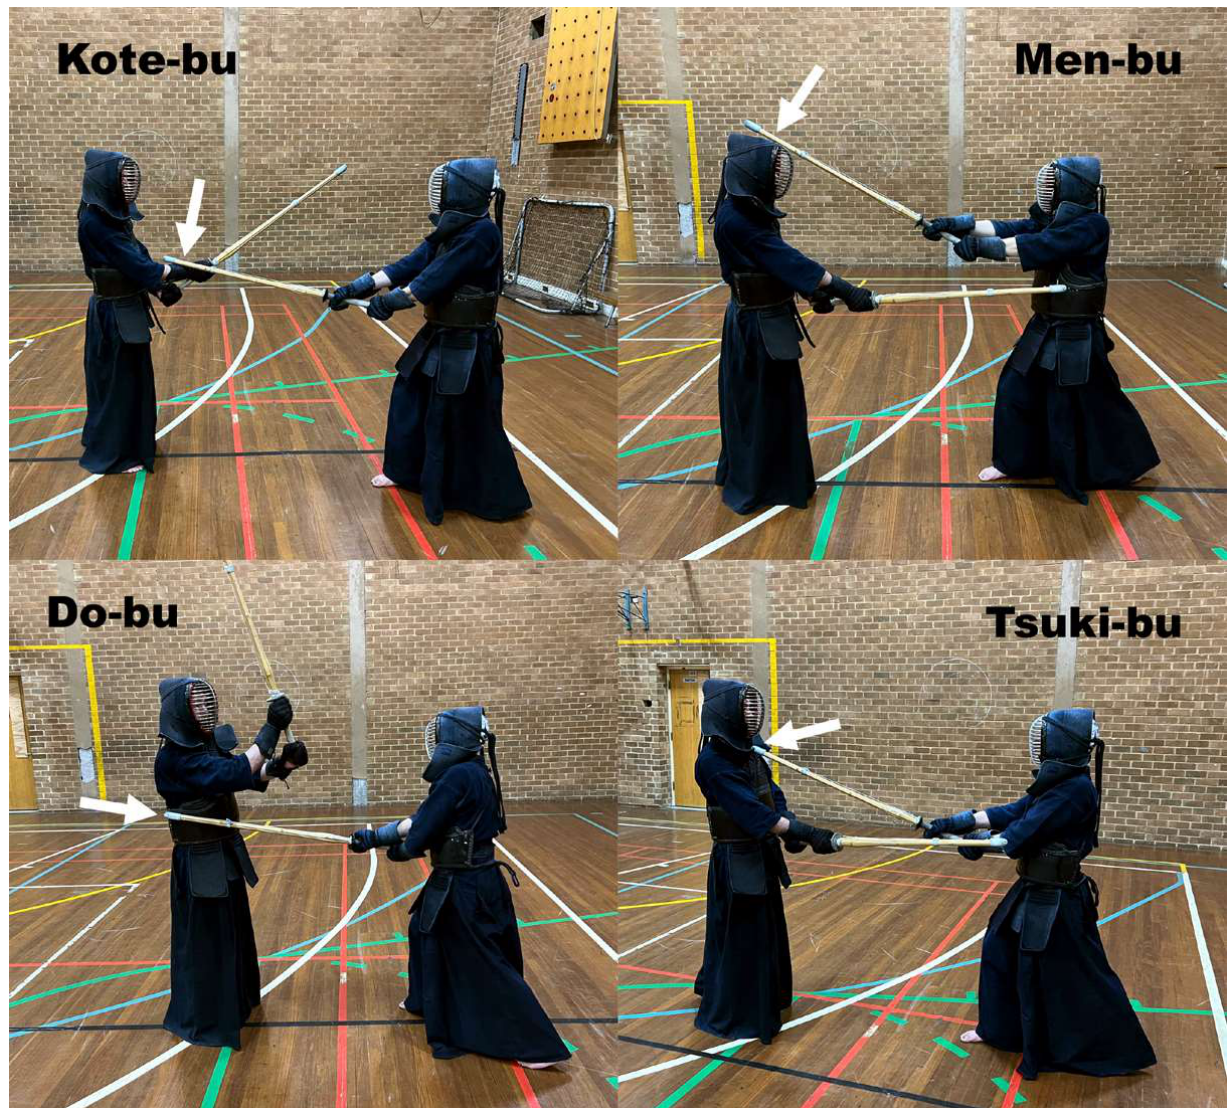
Figure 1. The four scoring targets in Kendo: wrist (Kote-bu), head (Men-bu), flank (Do-bu), and throat (Tsuki-bu).